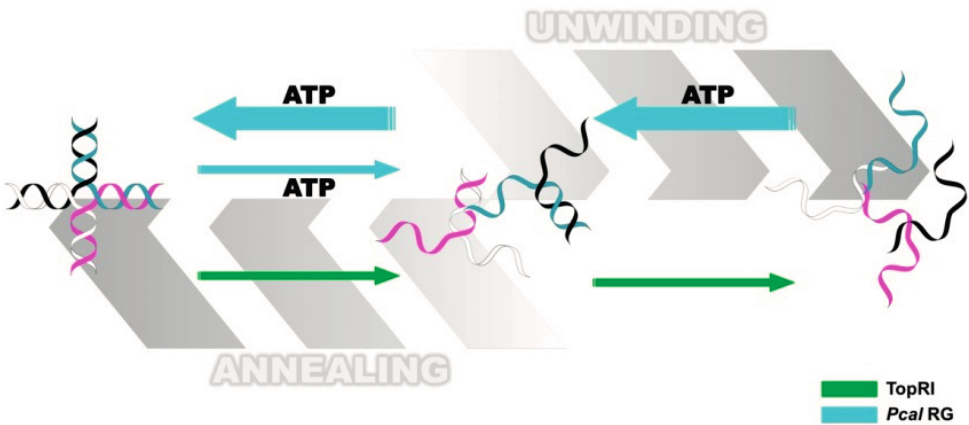
Figure 4. Diagram comparing the activities of the S. solfataricus TopR1 and P. calidifontis PcalRG reverse gyrases on synthetic Holliday junctions. Light blue arrows indicate PcalRG activities (ATP-dependent unwinding and ATP-indepedent annealing); green arrows indicate TopR1 ATP-independent unwinding; the four DNA strands are shown in white, pink, black and blue, respectively. Whereas TopR1 unwinding activity proceeds up to single strand oligonucleotides, the main products of PcalRG unwinding are Y-shaped forks, likely because single strand products are annealed back